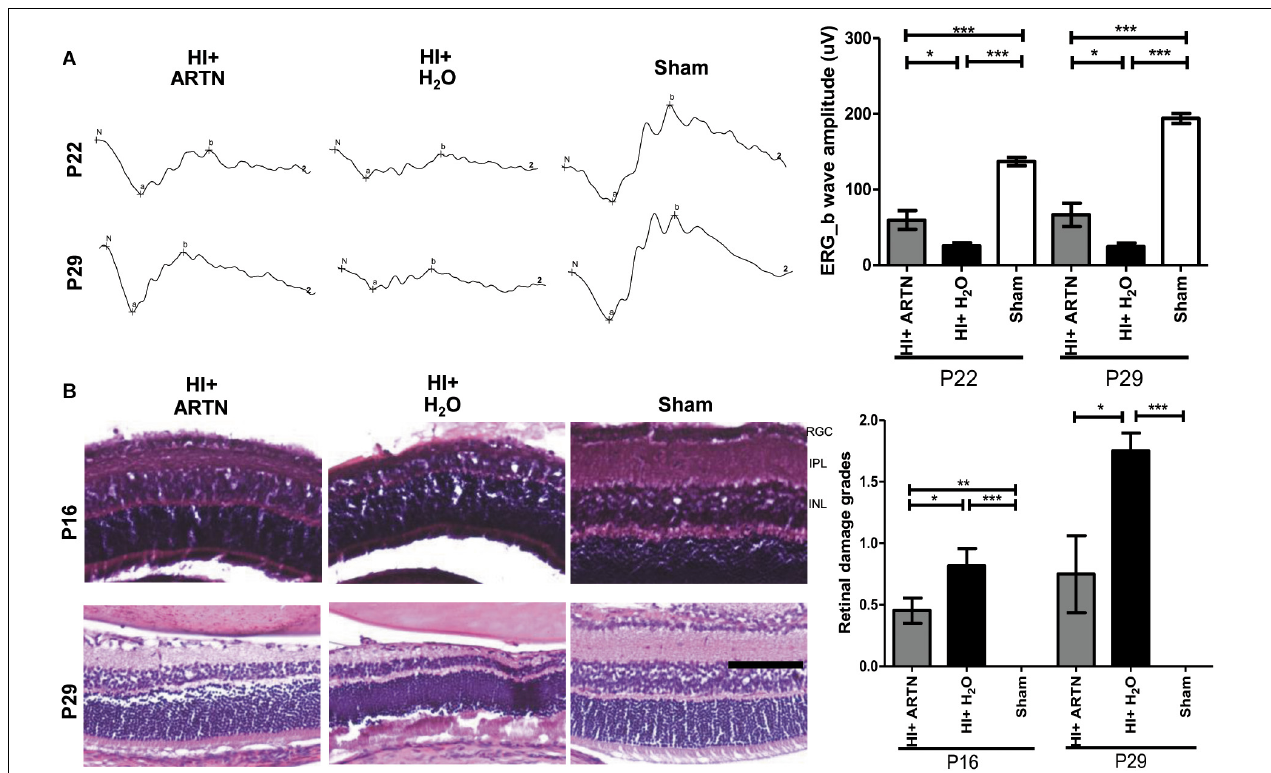
FIGURE 4 | Intravitreal injection of ARTN protects immature retinas against HI injury in both functional and histological levels. (A) At P22 and P29, the b-wave amplitudes of ERG were significantly decreased in the HI injured groups, as compared with the sham controls. The b-wave amplitude was significantly higher in the ARTN-treated as compared to in the H 2 O-treated group after HI. (B) Representative retinal histologic sections showed that the number of RGCs and the thickness of IPL and INL decreased after HI. The group data showed that the retinal damage grades were markedly higher in the H 2 O-treated HI group than the ARTN-treated HI group at P16 and P29. Scale bars: 100 µ m; n = 6–16 per group in each time point, power = 0.8, * p < 0.05, ** p < 0.01, *** p <